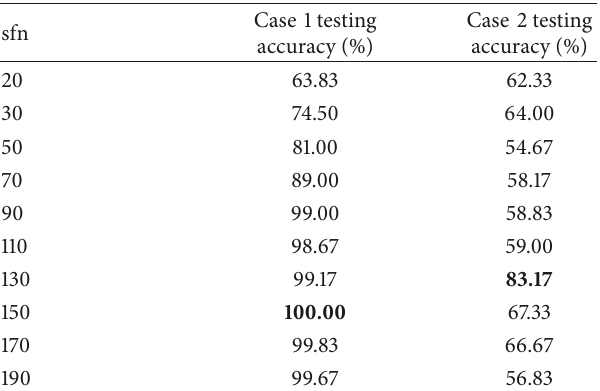
Table 22: Bearing fault diagnosis results obtained by the OFS- FSASD-LDA-SVM (dimension size is 11).